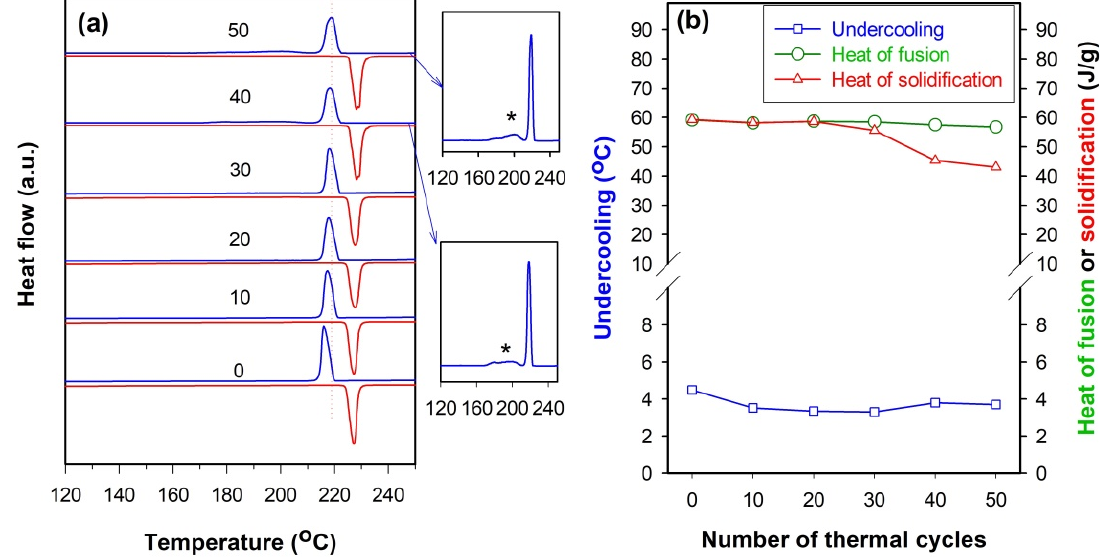
Figure 8. ( a ) DSC curves of SnZn 0.04 Cu 0.015 @SiO 2 microspheres (encapsulation times = 3) after different numbers of thermal cycles and ( b ) plot of both the undercooling and latent heat vs. the number of thermal cycles.